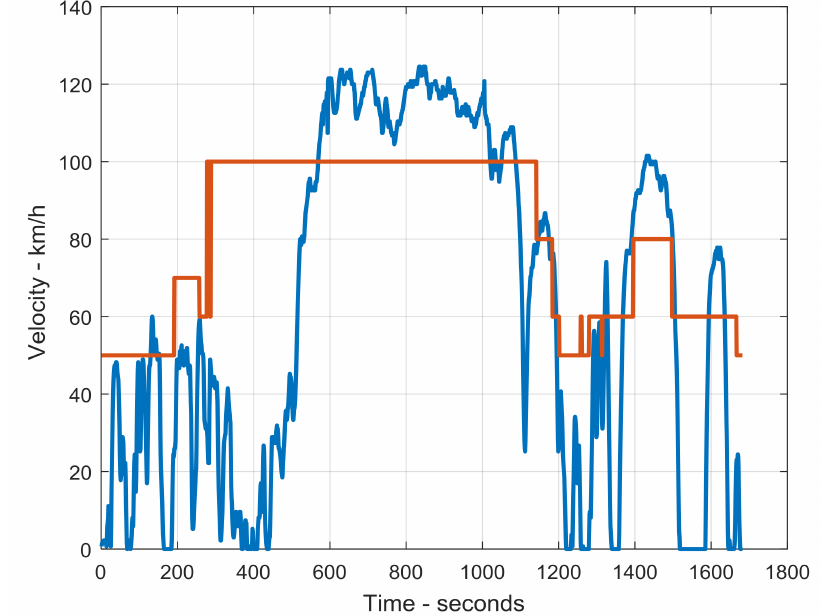
Figure 1. Driving speed (blue) as compared to posted speed (orange) of a trial trip by one of the authors